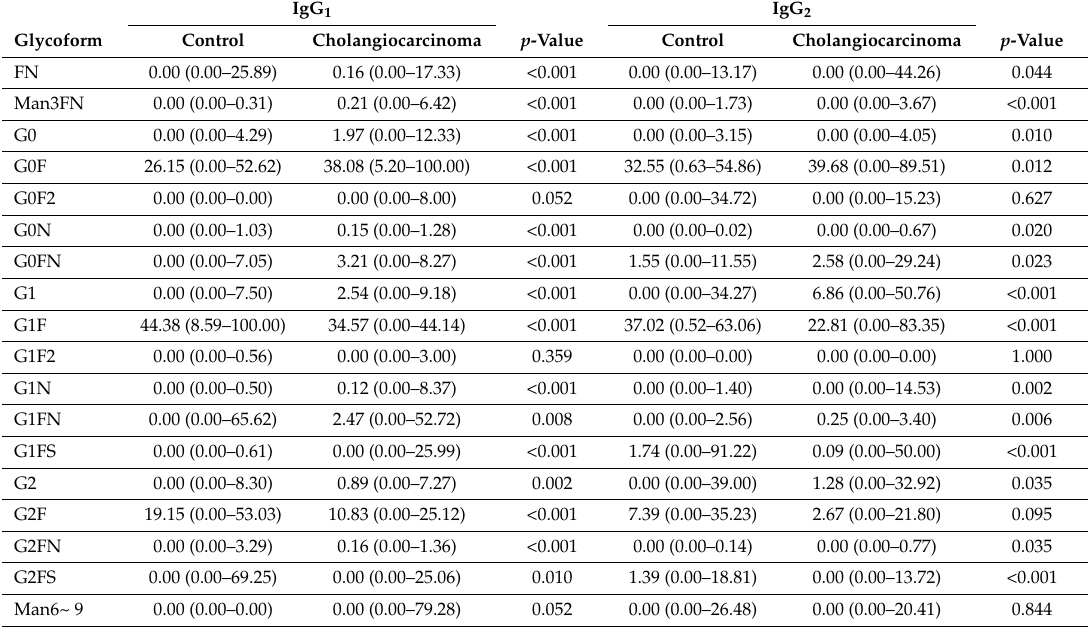
Table 2. IgG 1 -Fc and IgG 2 -Fc N -glycoprofiles in control subjects (n = 55) and in patients with cholangiocarcinoma (n =